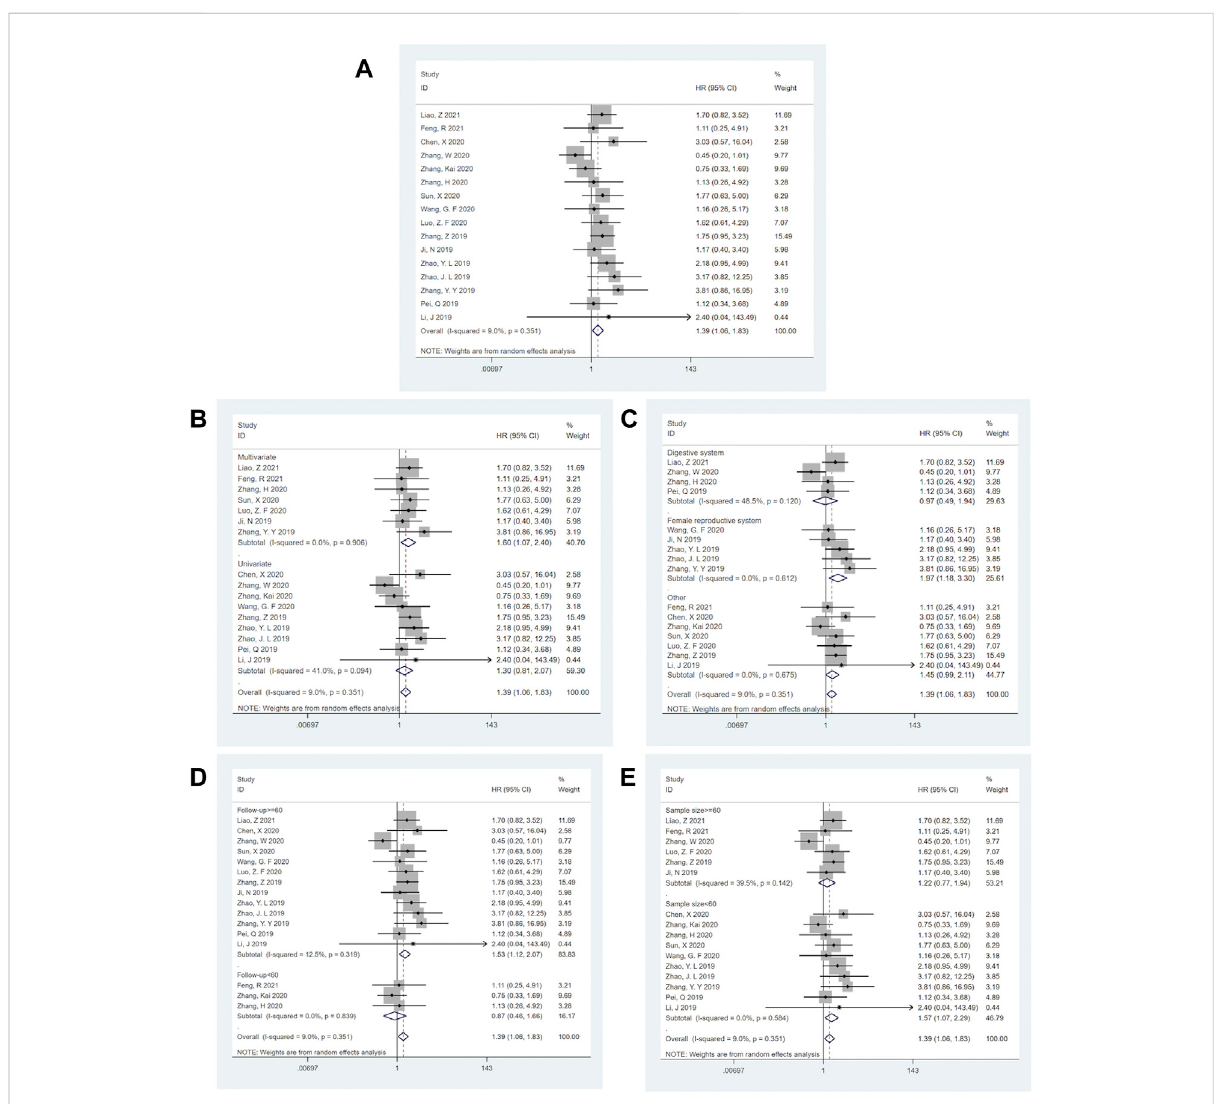
FIGURE 2 ForestplotsfortheassociationofSNHG14expressionwithoverallsurvivalandsubgroupanalysisofSNHG14expressionwithoverallsurvival. (A) Forest plots for theassociation of SNHG14 expressionwith overall survival. (B) Subgroupanalysisstrati fi edbyanalysis method. (C) Subgroup analysis strati fi ed by cancer type. (D) Subgroup analysis strati fi ed by follow-up time. (E) Subgroup analysis strati fi ed by sample